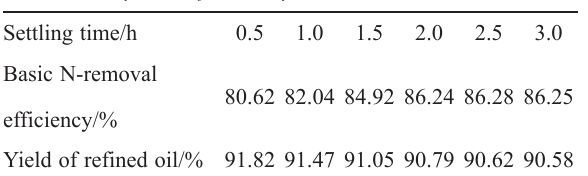
Table 3 – Effect of settling time on basic N-removal efficien- cy and refined oil yield Settling time/h